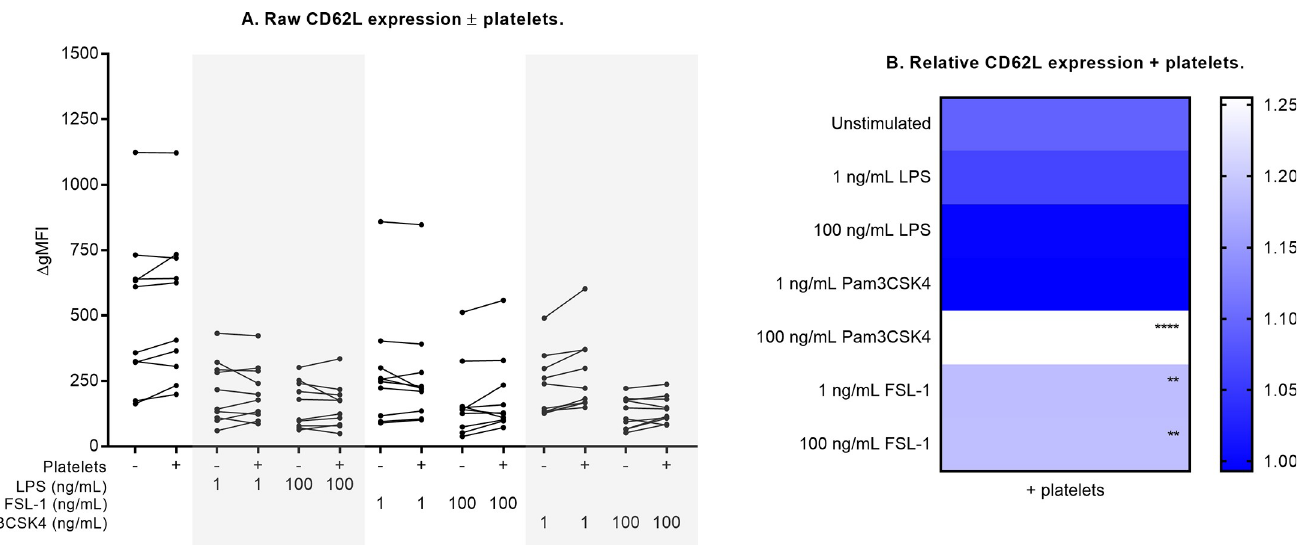
Fig 4. Neutrophil CD62L expression ± platelet co-culture. Raw CD62L expression results are shown in (A) for each culture condition, with each paired measurement (- platelets vs. + platelets) linked with a solid black line. CD62L expression is expressed on resting neutrophils, and is shed from the neutrophil surface in response to stimulation. Relative change in the presence of platelets is shown in (B), compared against measurements from neutrophil-only cultures, which were normalized to 1 (ble). Differences in expression (- platelets vs. + platelets) were examined by repeated measures two-way ANOVA with post-hoc Sidak multiple comparisons tests. �� p < 0.01, ���� p <